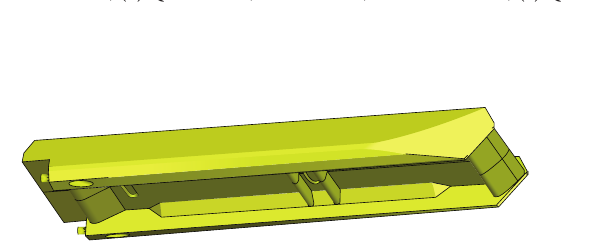
Figure 6: Geometric model of ONR T-Craft propelled by two AxWJ-2